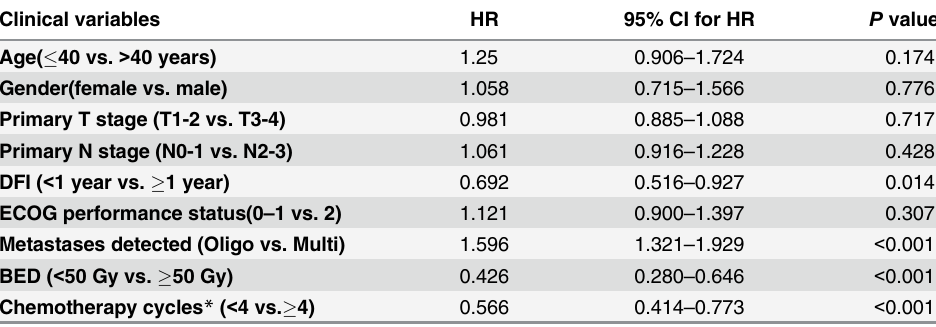
Table 2. Univariate analysis of clinical variables for metastatic survival